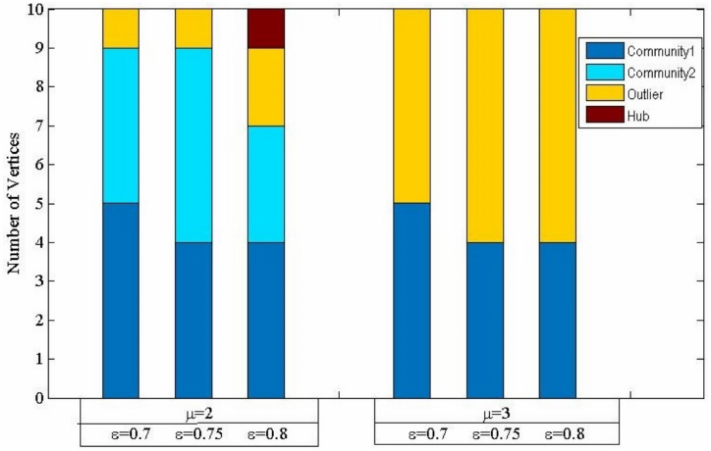
Figure 7. The spatial structural communities in the sample network using different